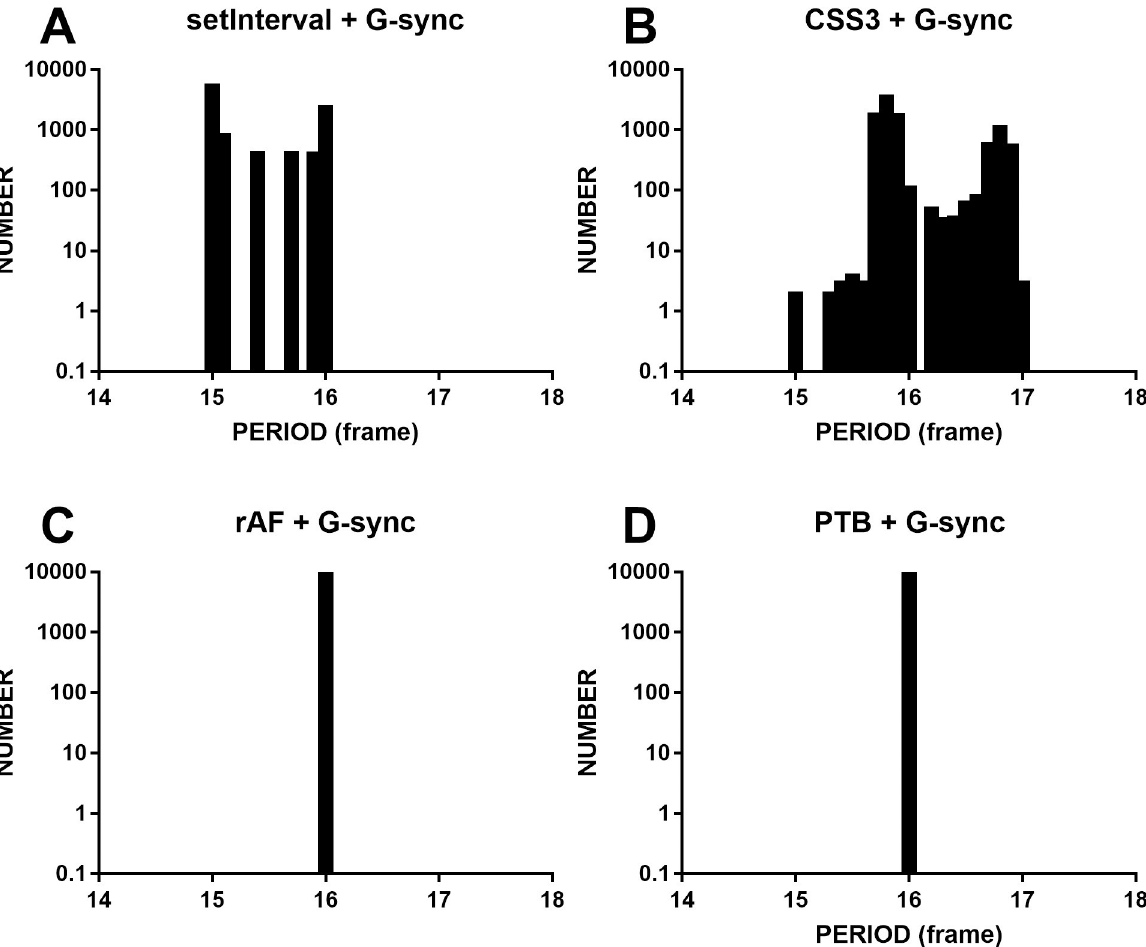
Fig 5. The four histograms are the periodic distributions of grating stimuli for the different methods in Chrome and PTB. The computer was powered by G-sync technology, and the refresh rate was 60 Hz. The titles of the subplots indicate the methods for producing the grating. The scattering of the bars in A and B indicates that G-sync did not improve the timing accuracies of setInterval and CSS3. The one bar in C and D indicates that the timing accuracies of rAF and PTB also did not benefit from G-sync.